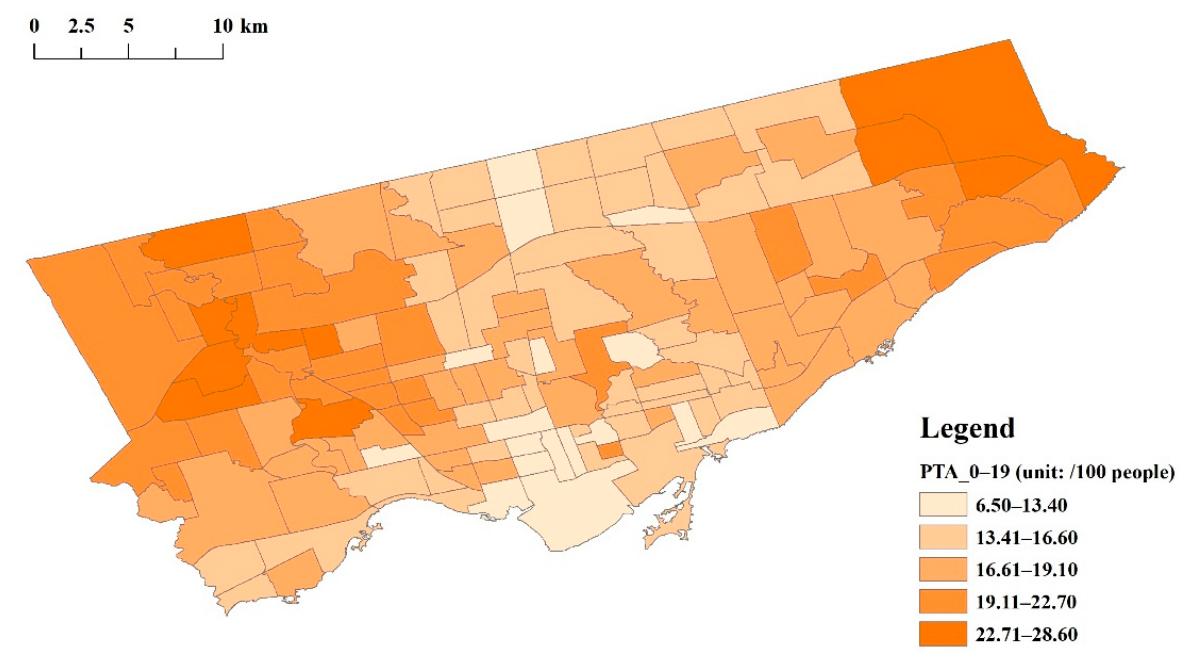
Figure A6. Distribution of the prevalence of total asthmatics aged 0–19 years (PTA_0–19).